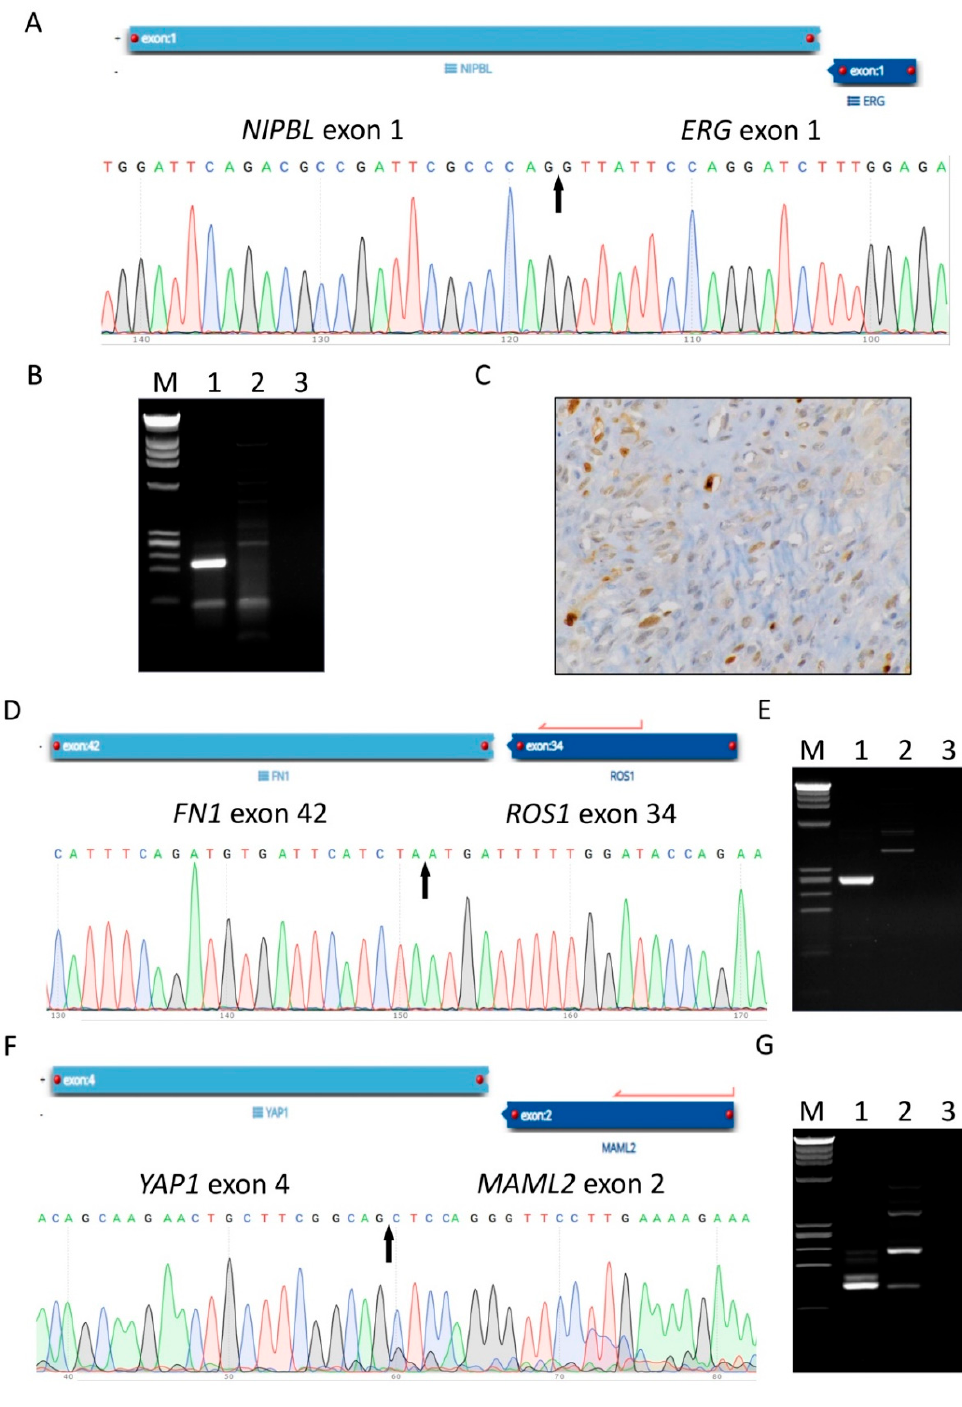
Figure 3. Discovery and validation of the novel gene fusions in atypical TGCTs. A partial sequence chromatogram is shown from each fusion transcript, with the arrow depicting the fusion breakpoint. Gel electrophoresis images display respective cDNA fragment amplification. A positive band can be seen in Lane 1, supporting the presence of the fusion product. M, DNA marker (Promega, Madison, WI, USA); Lane 1, patient case; Lane 2, HapMap normal RNA control; Lane 3, no template control (water control). ( A , B ) Identification and validation of NIPBL-ERG fusion transcript by anchored multiple PCR (AMP), Sanger sequencing, and RT-PCR. ( C ) ERG overexpression in the mononuclear tumor cells by immunohistochemistry (IHC). Identification and validation of FN1-ROS1 ( D , E ) and YAP1-MAML2 ( F , G ) fusion transcripts by AMP, Sanger sequencing, and RT-PCR.